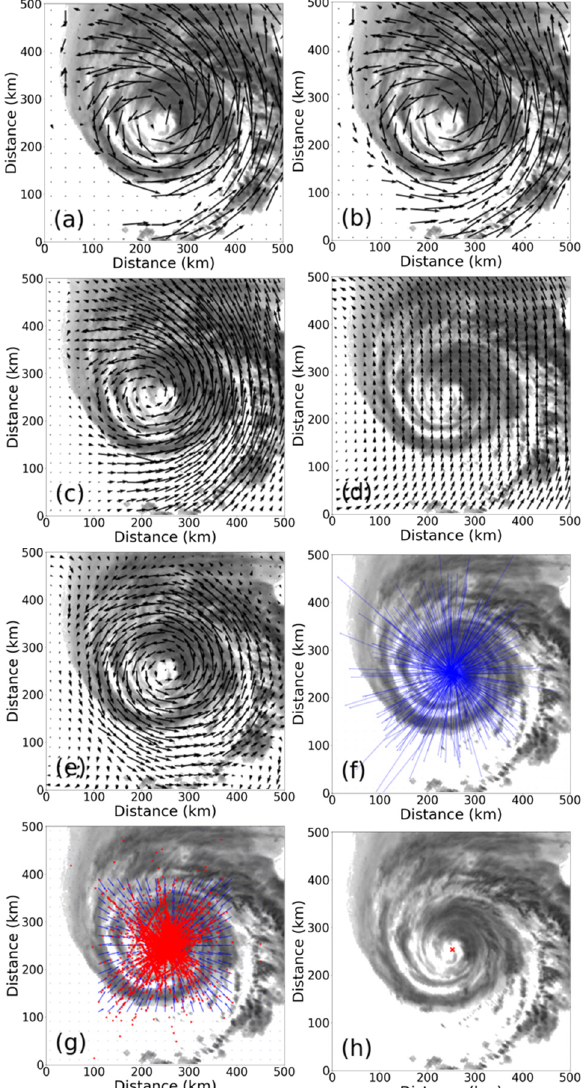
Figure 5. ACTION algorithm process: ( a ) basic motion vector calculation, ( b ) valid vector field calculation, ( c ) dense vector field generation, ( d ) background airflow extraction, ( e ) TC rotation component extraction, ( f ) tangential(blue line) intersection generation of rotation components, ( g ) intersection(red dot) maximum density calculation, and ( h ) TC center selection.